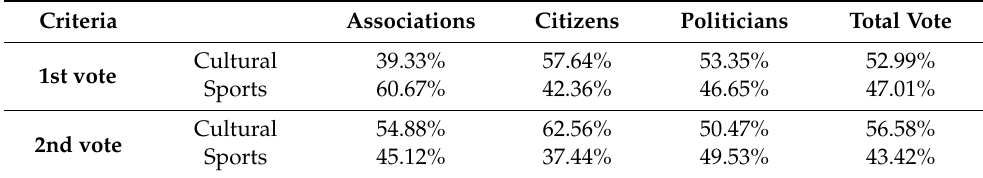
Table 4. Priorities of the criteria of each group of actors.